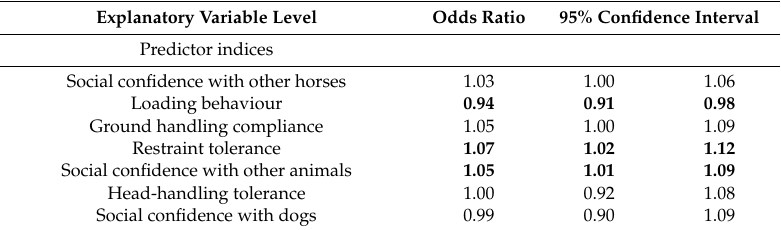
Table 6. Linear regression results: Predictor variables, including the seven created predictor indices (rotated components), found to be associated with safety-from-buck scores from owner-reported data on 1584 horses. Significant values with p < 0.05 displayed in bold. Positive estimates indicate increased safety-from-buck and negative estimates indicate decreased safety-from-buck. The coe ffi cient estimates were transformed, and horse age was modelled as a continuous variable. A linear relationship between age and safety-from-buck was determined by visual inspection.